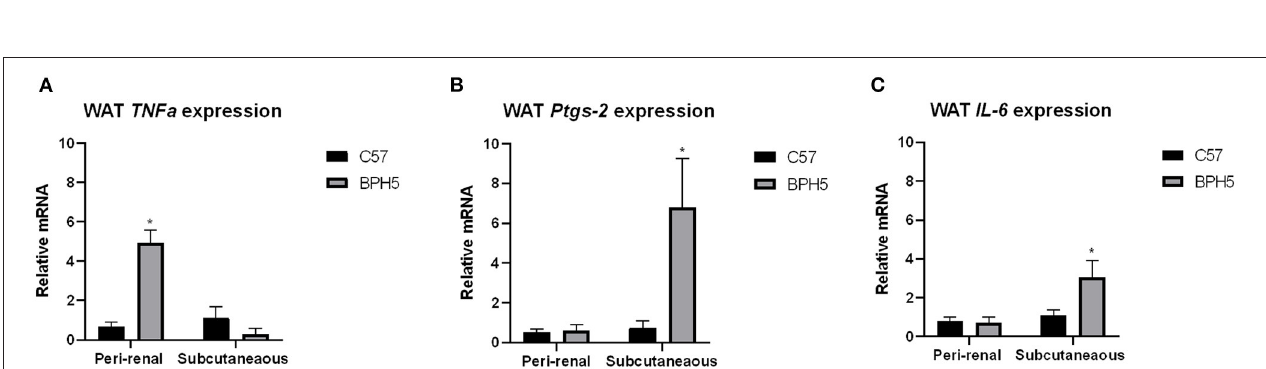
FIGURE 3 | Adult BPH/5 male mice exhibit increased inflammatory mediators within peri-renal and subcutaneous white adipose tissue (WAT). (A) Using real-time PCR, adult BPH/5 males have significantly increased tumor necrosis factor alpha ( TNFa ) relative mRNA expression in the peri-renal WAT; (B) prostaglandin synthase 2 ( Ptgs-2 ) relative mRNA expression was significantly increased in subcutaneous WAT; and (C) interleukin-6 ( IL-6 ) mRNA expression was significantly increased in the subcutaneous WAT ( n = 3–8/group; * p < 0.05 vs. C57).